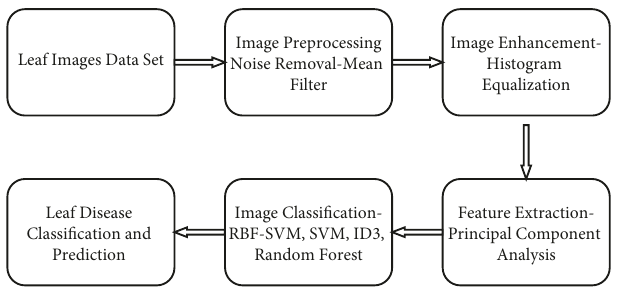
Figure 1: Block diagram of leaf disease detection by image pro- cessing and machine